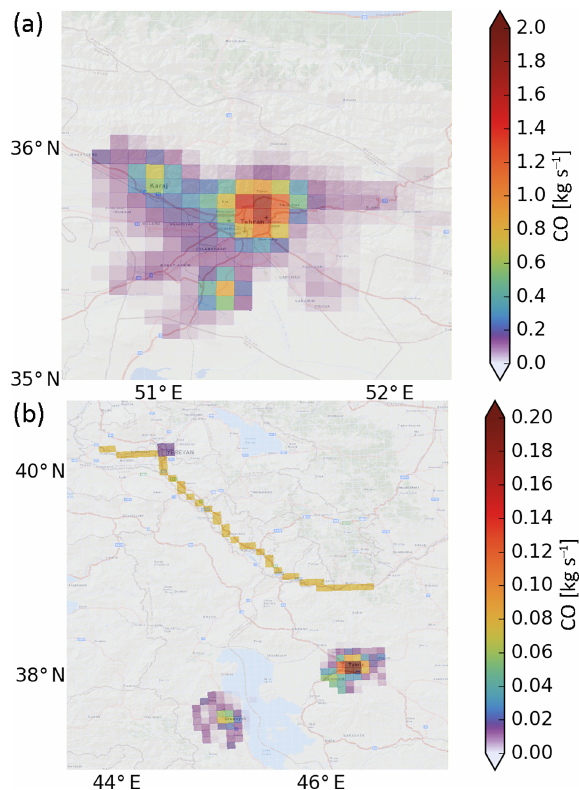
Figure 2. Emission used for the WRF tracer runs. Emission 70km around Tehran (a) extracted from EDGAR. (b) The emissions of Yerevan, Tabriz, and Urmia extracted from EDGAR 30km around the cities, and the additionally introduced emission along a main traffic road in Armenia not present in